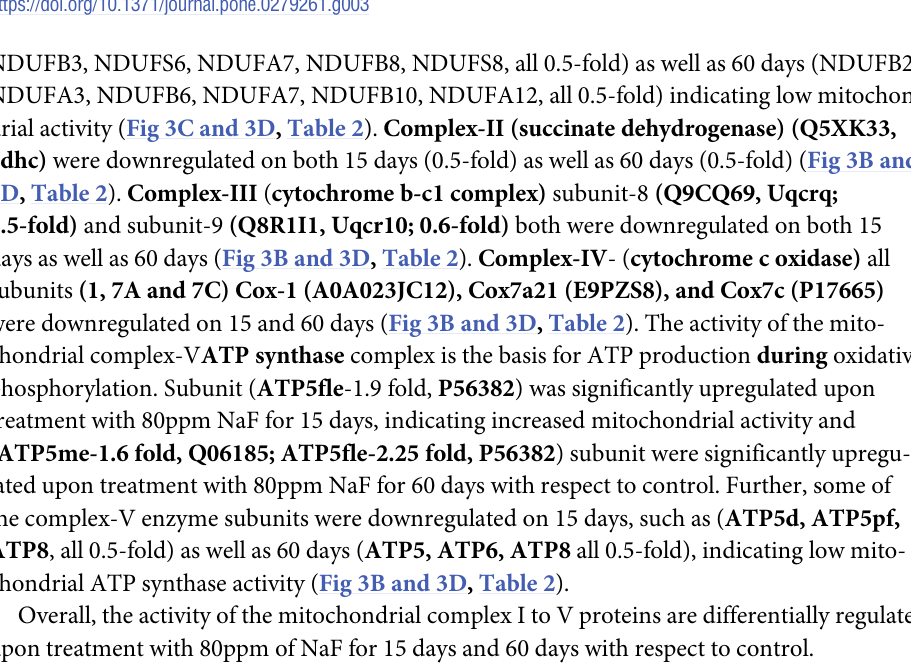
Fig 3. Differential expression of muscle proteins exposed to NaF 80ppm for 15 days. A & B) The volcano plot shows the distribution of proteins (up-regulated and down-regulated) upon short-term exposure to NaF. Differential expression of muscle proteins exposed to NaF 80ppm for 60 days. C & D) The volcano plot shows the distribution of proteins (up-regulated and down-regulated) upon long-term exposure to NaF.